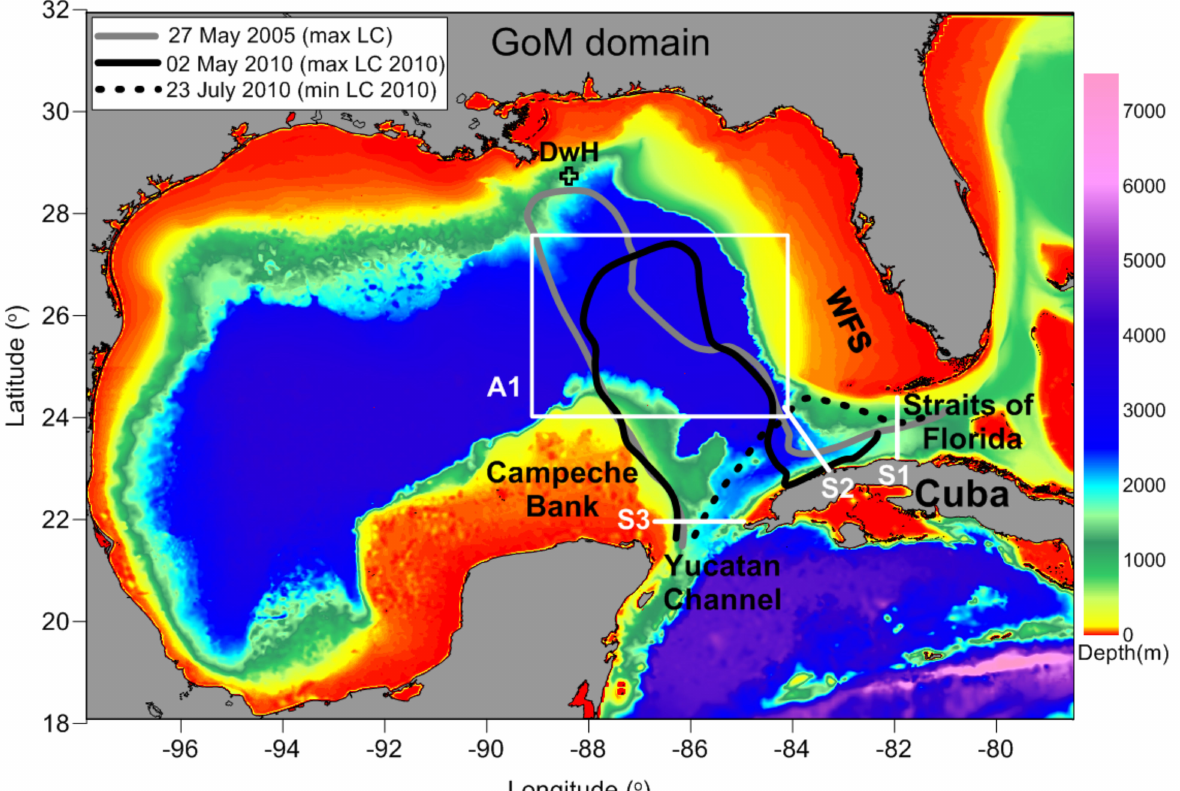
Figure 1. Topography of the model domain. Geographical locations mentioned in the text: Gulf of Mexico (GoM), Yucatan Channel, Campeche Bank, Cuba, Straits of Florida and West Florida Shelf (WFS). The sea surface height 17-cm contour, derived from the AVISO Maps of Absolute Dynamic Topography (MADT) fields, during the maximum Loop Current (LC) extension of the 1993–2016 period (27 May 2005) and the maximum (2 May) and minimum LC (23 July) extensions of 2010 are marked with solid grey, solid black and dashed black lines, respectively. Sections S1, S2 and S3 and area A1 are indicated with white lines. The location of the Deepwater Horizon (DwH) platform is marked with a